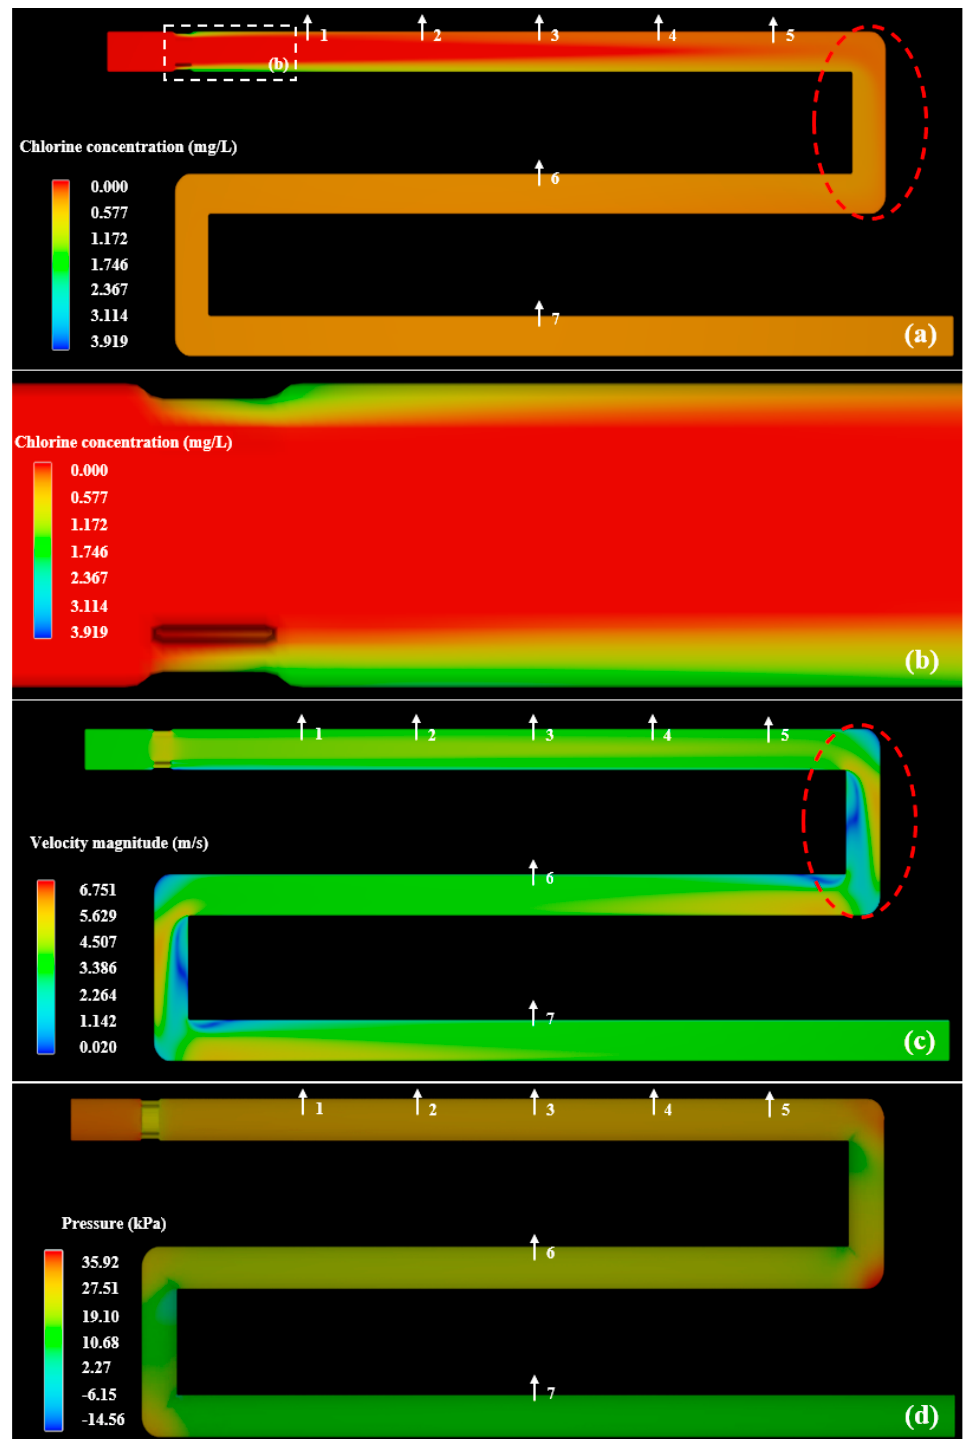
Figure 7. Fluid contour images from CFD simulation of the electro-chlorination experiment. Inlet flow rate is 800 L min − 1 . Outlet pressure was set to 10.8 kPa. ( a ) Chlorine concentration; ( b ) expanded view of electrode side in image (a); ( c ) velocity magnitude; ( d ) pressure.